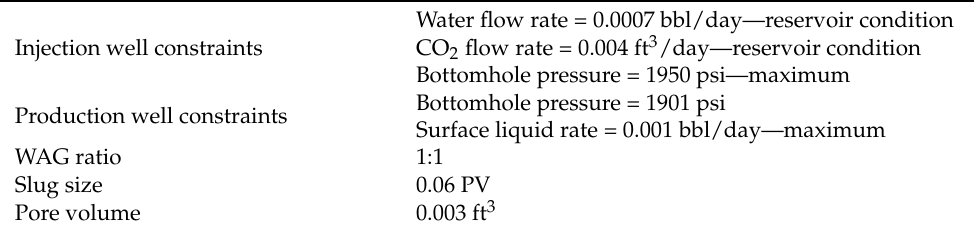
Table 5. Injection well and production well constraints are the same for CO 2 continuous flooding, differing only from the non-existence of a water flow. Table 5. Operating